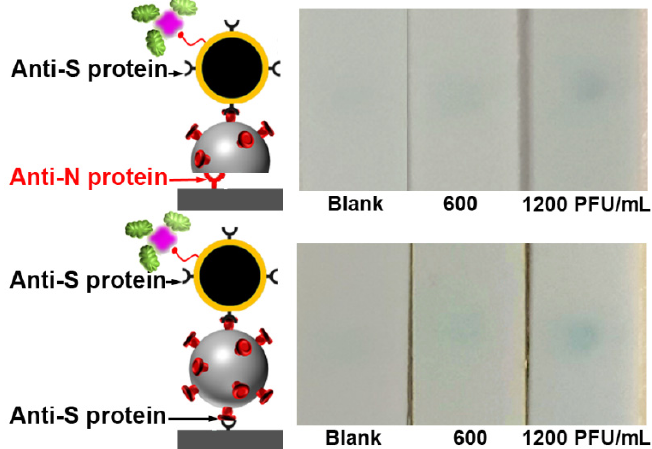
Figure 2. mLFA detection results with anti-spike protein antibody-modified magnetic probes on LF strips immobilized with anti-spike protein antibodies and anti-nucleocapsid protein antibodies, respectively.